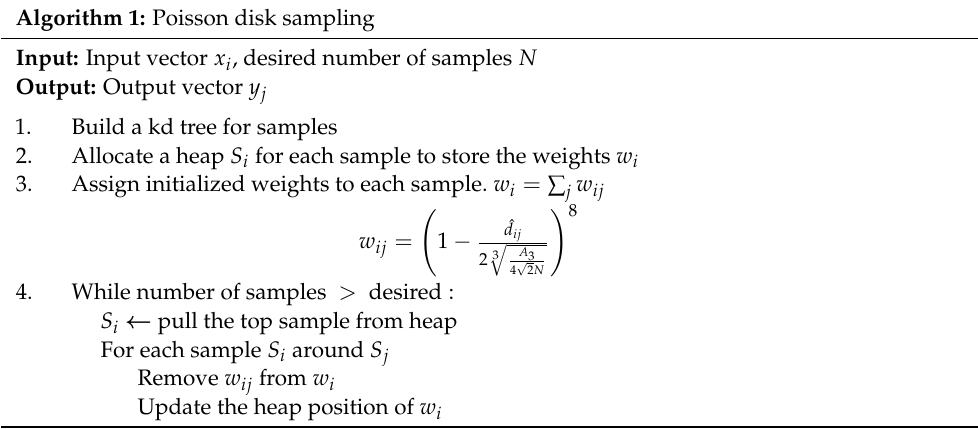
Algorithm 1: Poisson disk